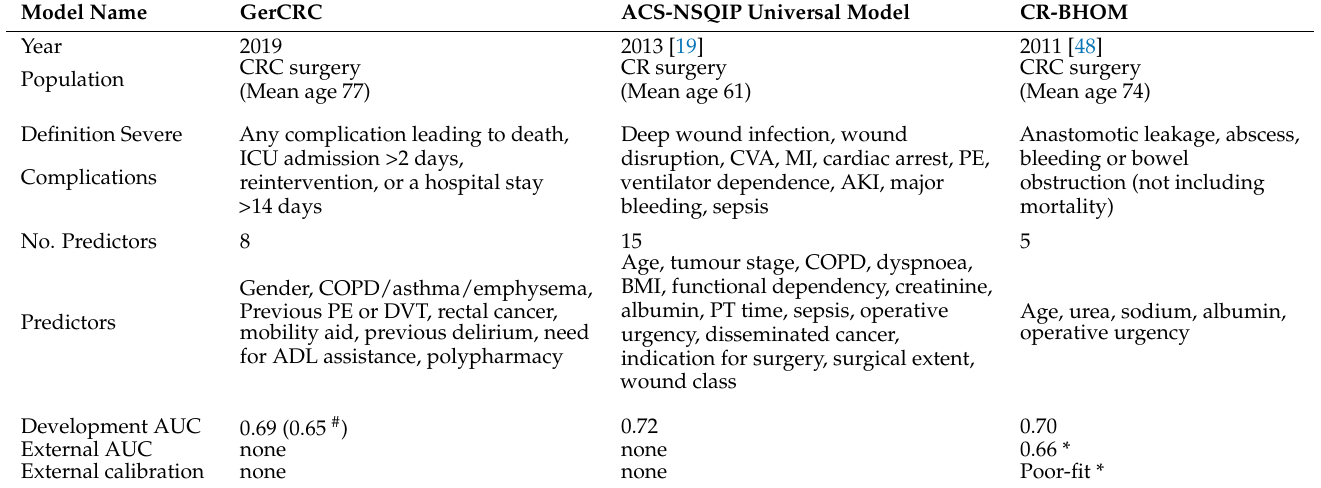
Table A3. Comparison of Three Preoperative Risk Prediction